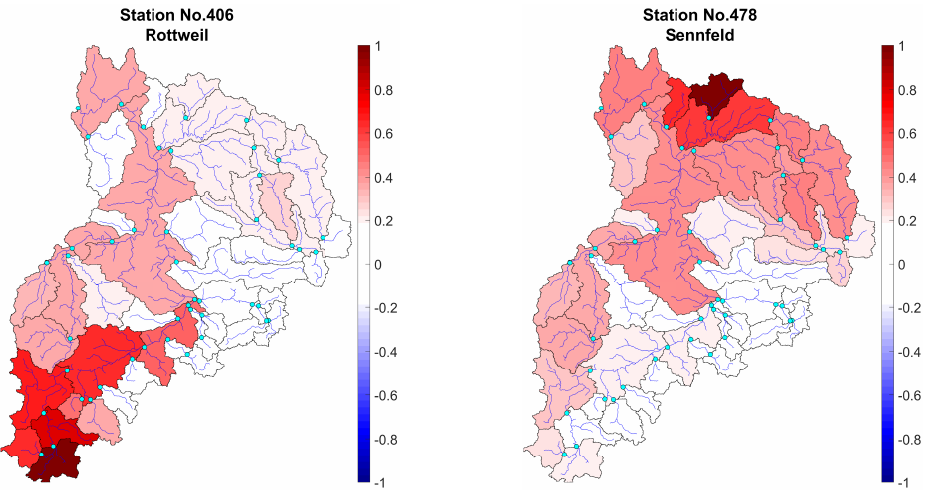
Figure 5. The simultaneous occurrence of the most significant floods regarding the reference stations; ( Left ) Rottweil; ( Right )